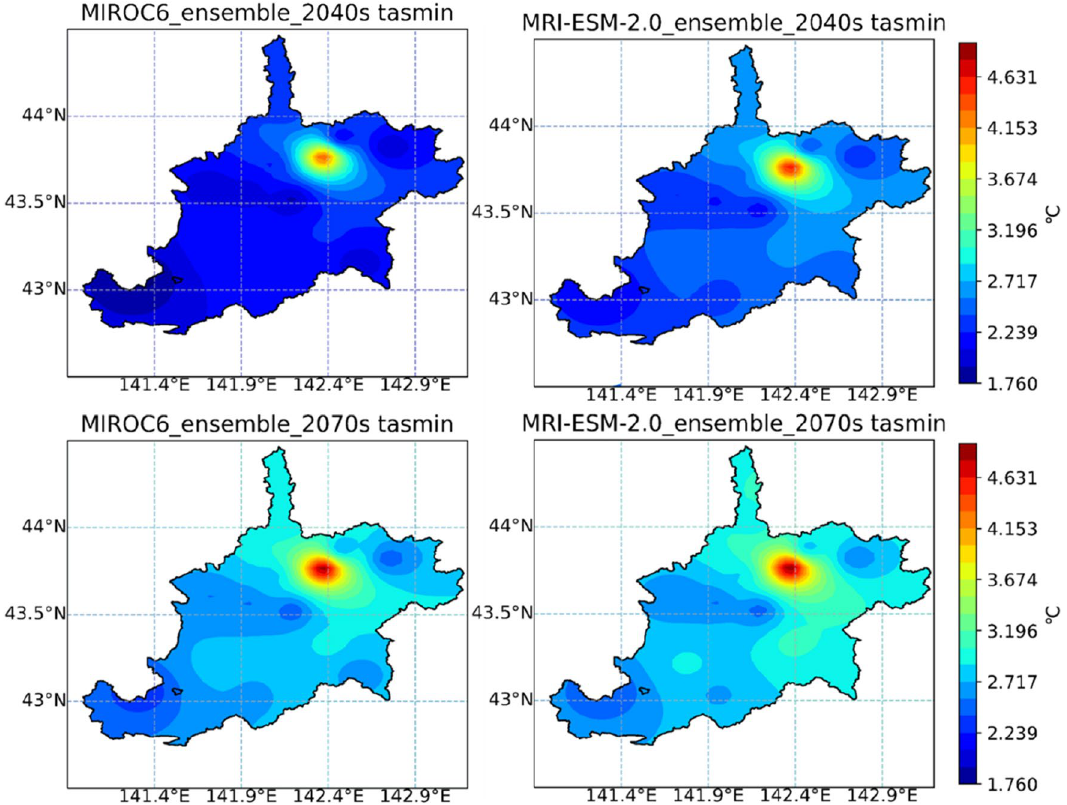
Figure 11. Changes in the minimum temperature (tasmin) of the Ishikari River basin in periods of the 2040s and 2070s under MIROC6 and